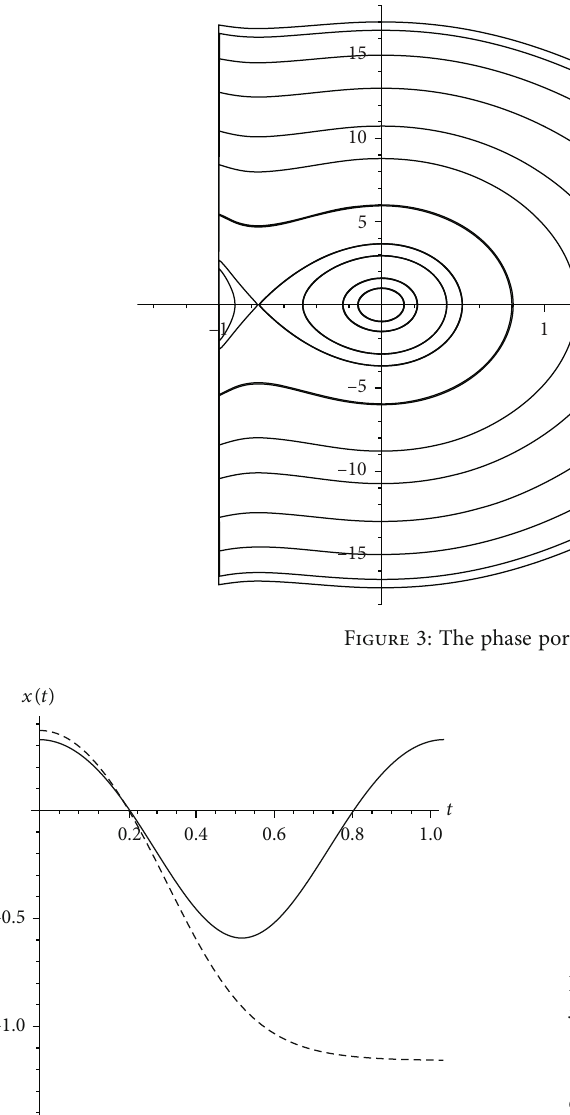
Figure 4: Graphs x ð t Þ for solutions of problems (15) and (30), x ≈ 0 : 352 , x ≈ 0 : 40228 (dashed). α